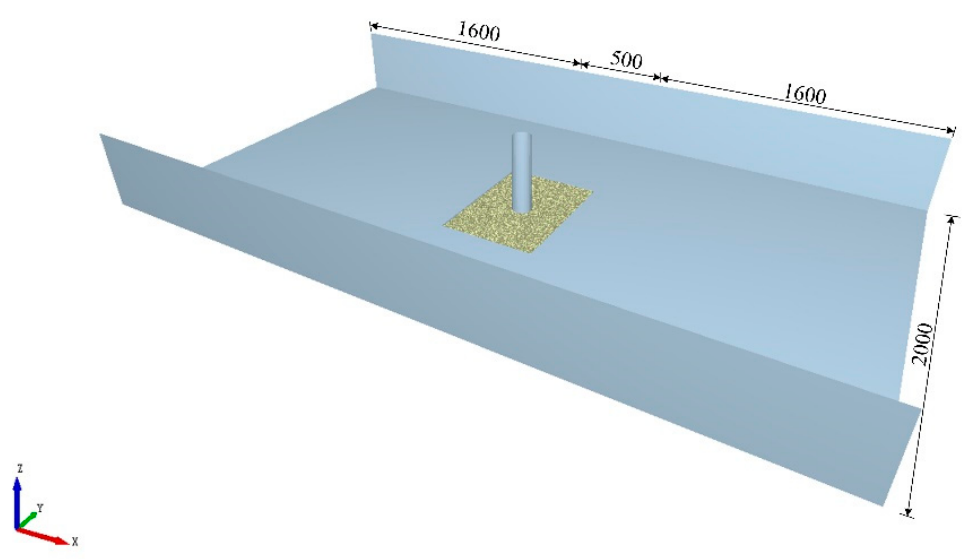
Figure 2. Geometric model (unit: mm).